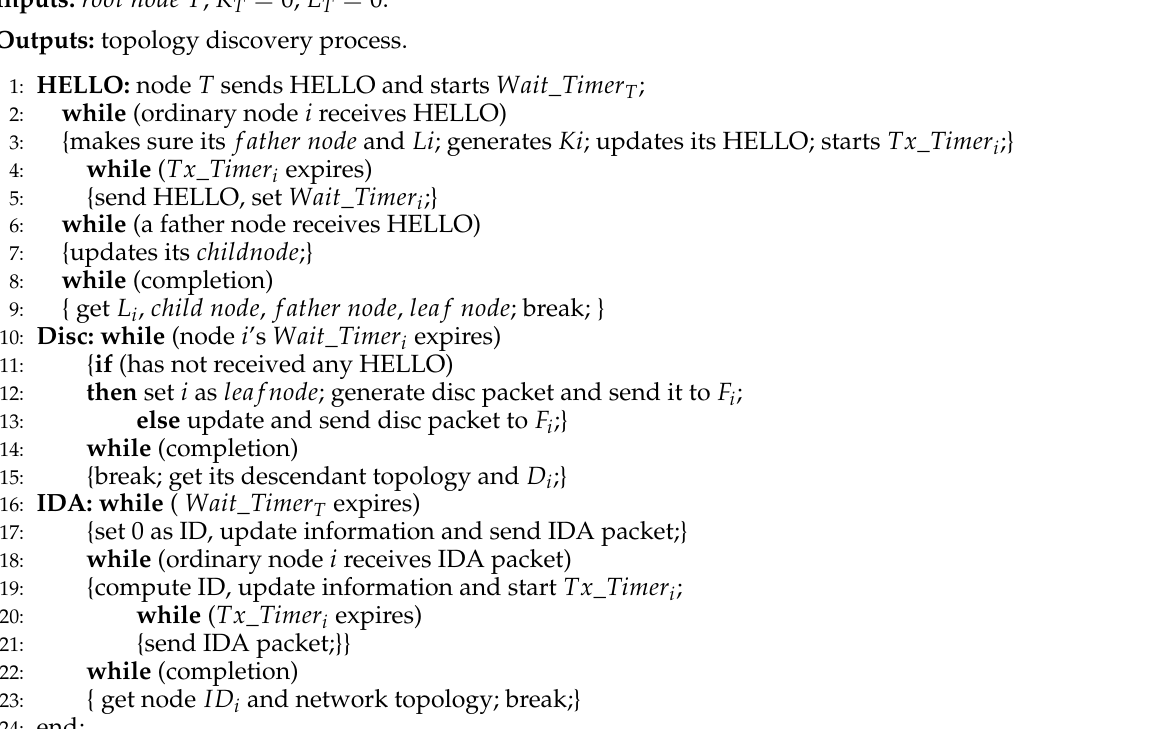
Algorithm 1 Topology Discovery